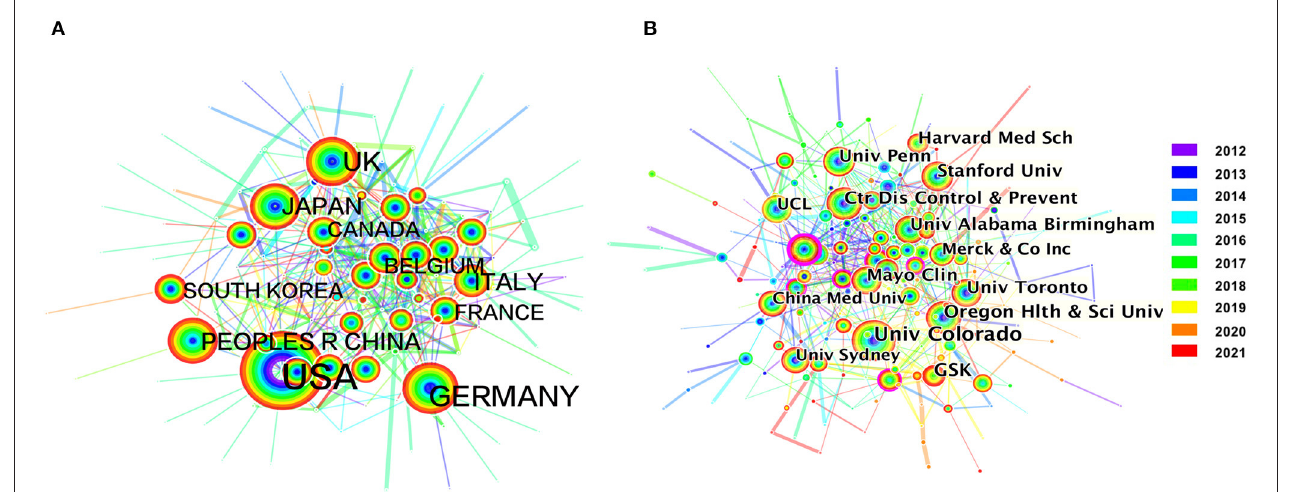
FIGURE 2 | The network map of collaborating countries/regions (A) and institutions (B) in herpes zoster research.